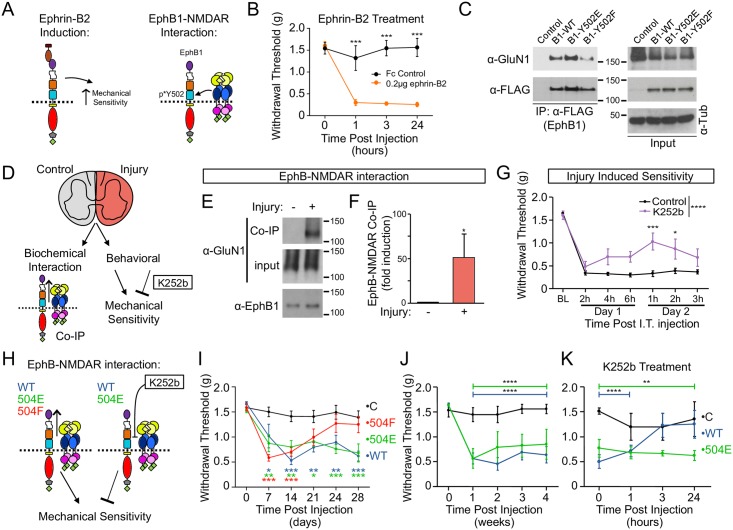
Pain sensitivity is regulated by EphB2 Y504 and extracellular phosphorylation.(A) Experimental approach for panels B–C is illustrated. (B) Quantification of the effects of intrathecal (I.T.) injection of ephrin-B2-Fc (0.2 μg) on mechanical sensitivity in adult mice (***p < 0.001, ANOVA followed by Dunnet’s multiple comparison test, n = 6 mice). (C) Co-immunoprecipitation (co-IP) of GluN1 and EphB1 with α-FLAG (EphB1) antibody from HEK293T. All lanes are transfected with HA-GluN1 and GluN2B. The control lane is transfected with enhanced green fluorescent protein (EGFP), the wild type (WT) lane is transfected with EphB1 WT, the E lane is transfected with EphB1 Y502E, and the F lane is transfected with EphB1 Y502F. Top blots were probed for GluN1, and bottom blots were probed for EphB1. The left panels are IP samples pulled down with α-FLAG antibody, and the right panels are lysates. Tubulin was used as a loading control. (D) Experimental approach for panels (E–G) is illustrated. (E) Adult mice underwent unilateral plantar incision. 24 hours following incision, their spinal cords were separated into ipsilateral (+) and contra-lateral (-) sides to injury. Endogenous EphB1 was immunoprecipitated with α-EphB1 antibody from these tissues. Blots were probed for GluN1 and EphB1. EphB1 is expressed in the spinal cord and interacts with the N-methyl-D-aspartate receptor (NMDAR) [25, 61]; therefore, for these experiments we used antibodies against EphB1. (F) Quantification of the effects of unilateral plantar incision on the EphB—NMDAR interaction (p < 0.05, Mann—Whitney U test, 8 spinal cords pooled per sample, n = 3). (G) Adult mice underwent plantar incision. Mice were given intrathecal injections of either vehicle control (black) or K252b (1 μg, purple) at the time of plantar incision and again 24 hours following incision (n = 6 mice for control and n = 5 mice for K252b) (for all graphs, *p < 0.05, **p < 0.01, ***p < 0.001, ****p < 0.0001, 1-way or2-way ANOVA followed by Dunnett’s multiple comparison test). (H) Experimental approach for panels (I–K) is illustrated. (I) Intrathecal injections of lentivirus transducing EGFP (black), enhanced yellow fluorescent protein (EYFP)-tagged EphB2 WT (blue), EphB2 Y504E (green), or EphB2 Y504F (red) were made into adult mice. Graph shows quantification of the effects of these injections on mechanical sensitivity in mice 1–4 weeks after injection of the virus (n = 8 mice for control before viral injection and n = 7 for 1–4 weeks after viral injection; n = 8 mice for EphB2 WT; n = 8 for EphB2 Y504E before viral injection; n = 7 for 2–4 weeks after viral injection; n = 8 for EphB2 Y504F). (J) Intrathecal injections of lentivirus transducing EGFP (black), EYFP-tagged EphB2 WT (blue), or EphB2 Y504E (green) were made into adult mice. Graph shows quantification of the effects of these injections on mechanical sensitivity in mice 1–4 weeks after injection of the virus (n = 6 mice for control, n = 8 mice for EphB2 WT, n = 6 for EphB2 Y504E before viral injection and n = 4 for 1–4 weeks after viral injection). Bars indicate the period of significant effects on sensitivity in EphB2 WT or Y504E-injected animals. (K) Four weeks after intrathecal injection of lentivirus transducing EGFP (black), EYFP-tagged EphB2 WT (blue), or EphB2 Y504E (green), mice were given intrathecal injections with K252b (1 μg), and effects on mechanical sensitivity were monitored at 1, 3, and 24 hours after injection (n = 6 mice for control before K252b injection and n = 3 mice for control after K252b injection; n = 6 mice for EphB2-WT before K252b injection and 1 hour after K252b injection; n = 5 mice for EphB2-WT 3 hours and 24 hours after K252b injection; n = 6 mice for EphB2-Y504E). Bars indicate period of significant effects on sensitivity in EphB2 WT or Y504E-injected animals following K252b injection. K252b reduced mechanical sensitivity in EphB2 WT—transduced but not in EphB2 Y504E—transduced mice.